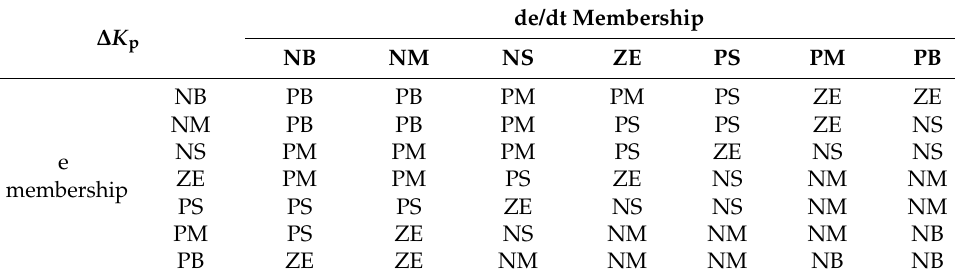
Table 1. ∆ K p fuzzy rule table.